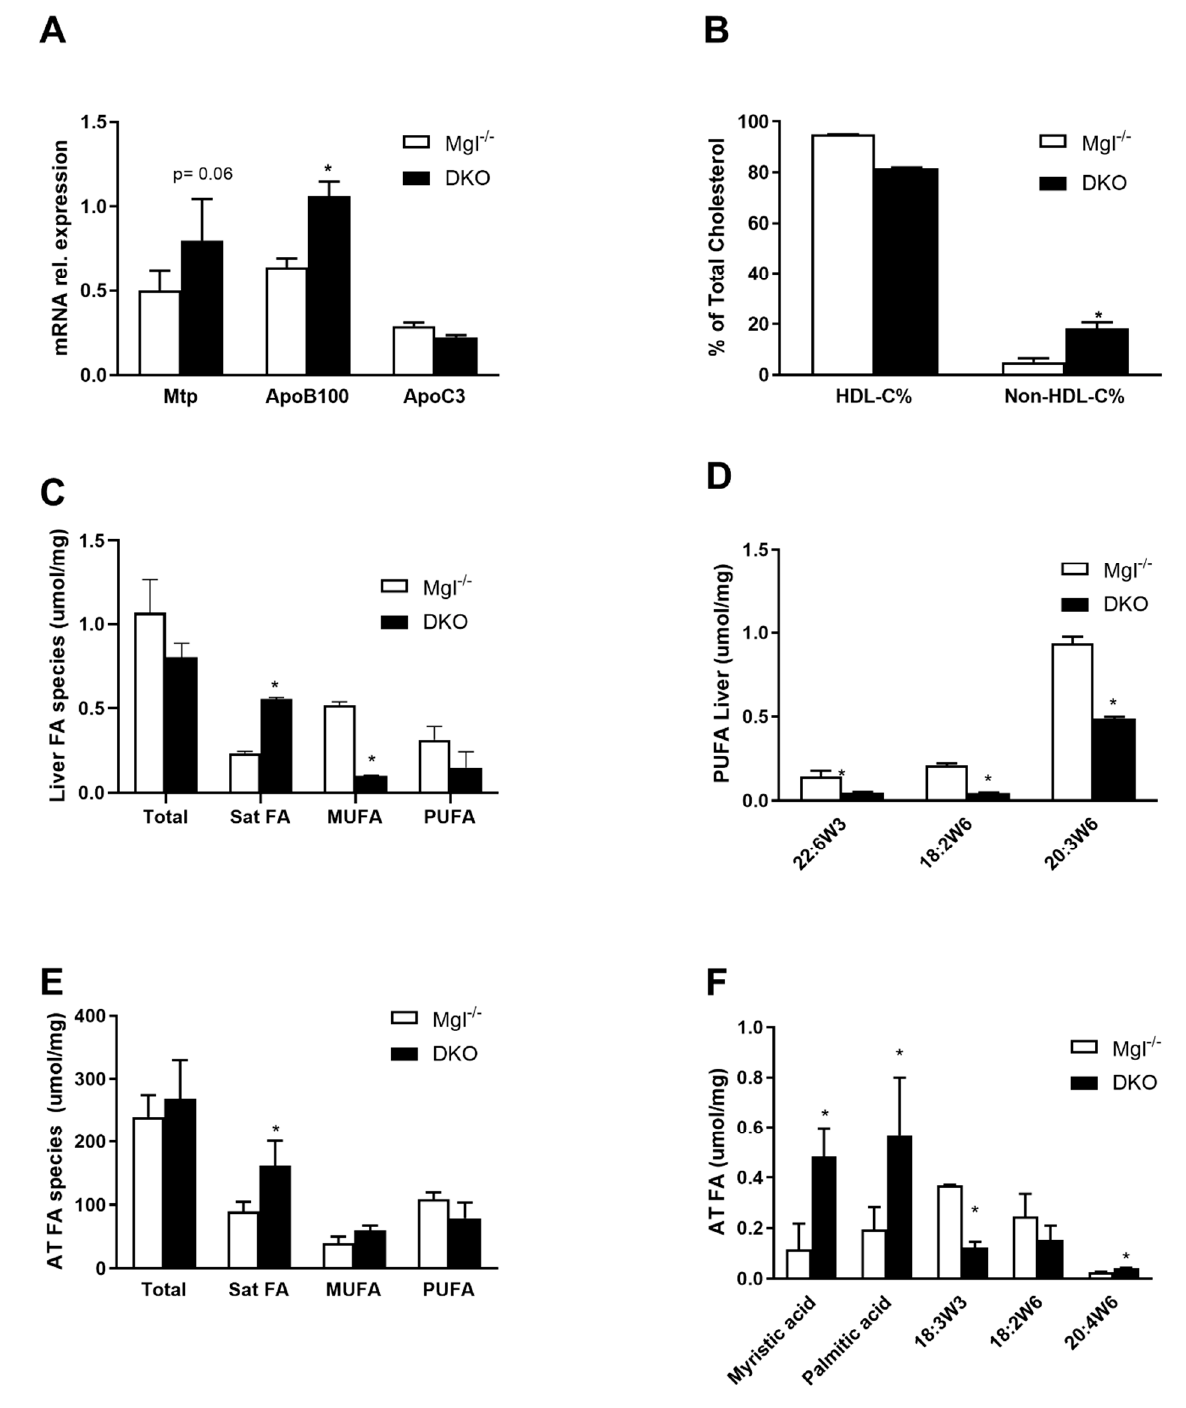
Figure 2. DKO shows enriched fatty acid (FA) species in liver and AT. ( A ) Gene expression of genes involved in very low-density lipoprotein (VLDL) production was increased for Mtp and ApoB100, whereas the ApoC3 gene for HDL was unchanged. ( B ) HDL-C% and respective non-HDL-C% were measured in serum. ( C ) Gas chromatography quantification of hepatic FA evidenced accumulation of saturated FAs with a decrease in monounsaturated fatty acids (MUFAs) and polyunsaturated fatty acids (PUFAs) in DKO ( D ) of 18:2w6 and 20:3w6 diminished in DKO . ( E ) In the AT, saturated fatty acids (SFAs) accumulated with ( F ) increased mystiric acid, palmitic acid, and decreased 18:2w3/6. Results are expressed as mean ± S.D.; * p <0.05 for Mgl -/- versus DKO mice.